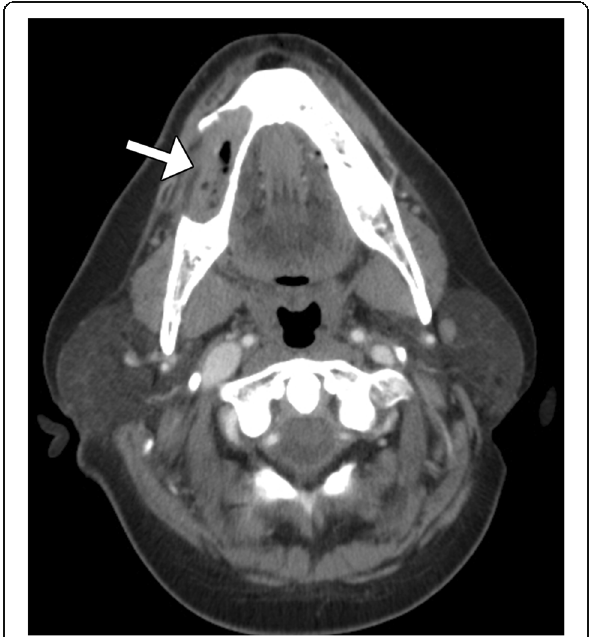
Fig. 8 Ameloblastic carcinoma. Axial CT image shows a lytic lesion involving the right mandible